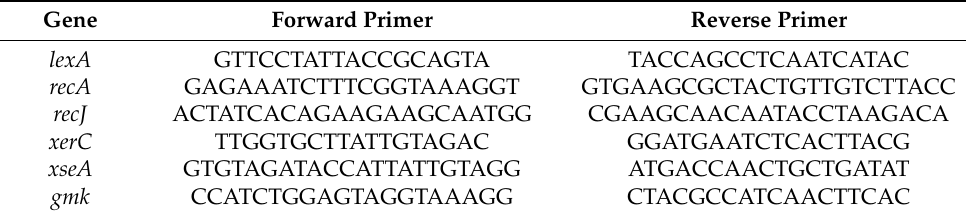
Table 1. Primer sequences for real-time